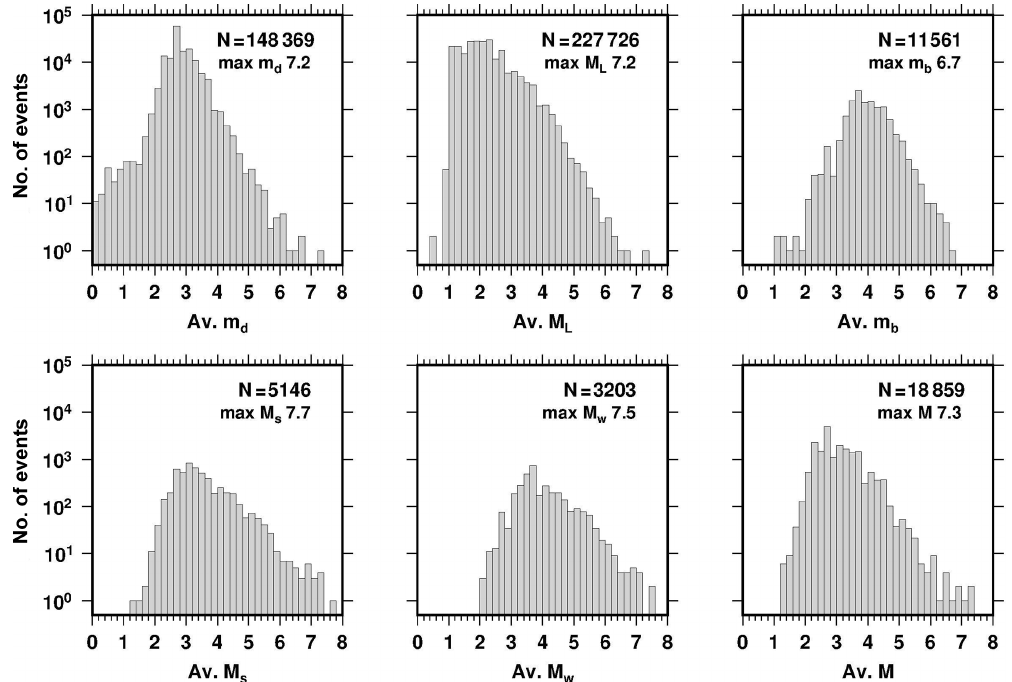
Figure 4. The number of events in the final catalogue for each average magnitude (1964–2018). N is the total number of events for each